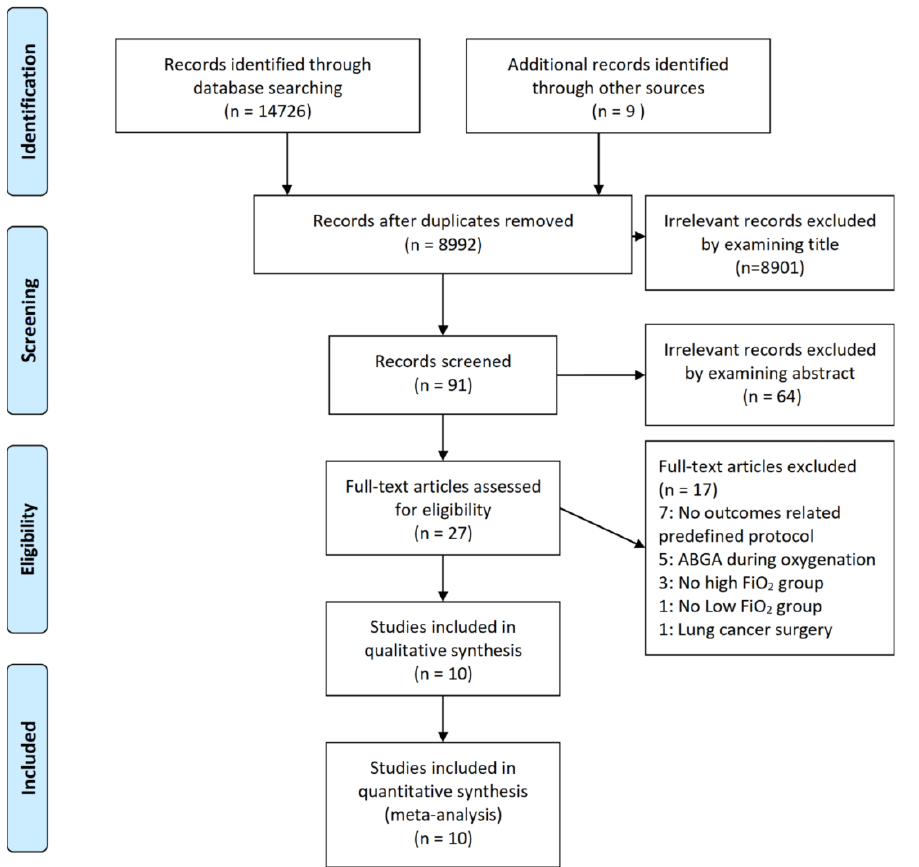
Figure 1. Flow diagram of included and excluded studies.